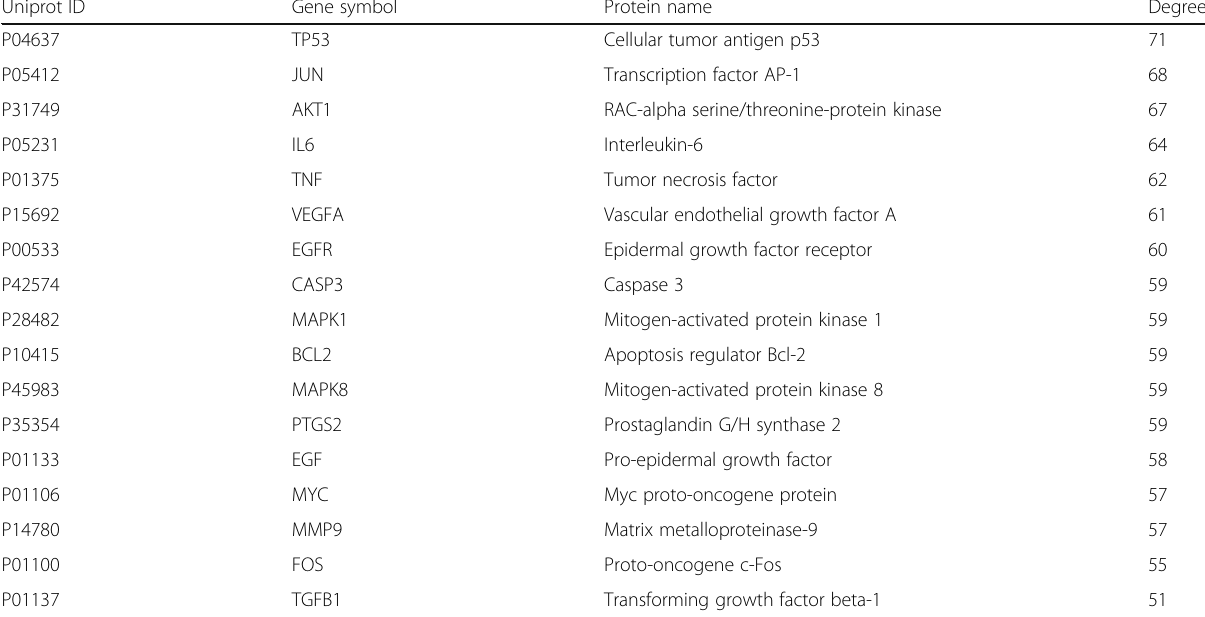
Table 1 Information on 17 hub targets Uniprot ID Gene